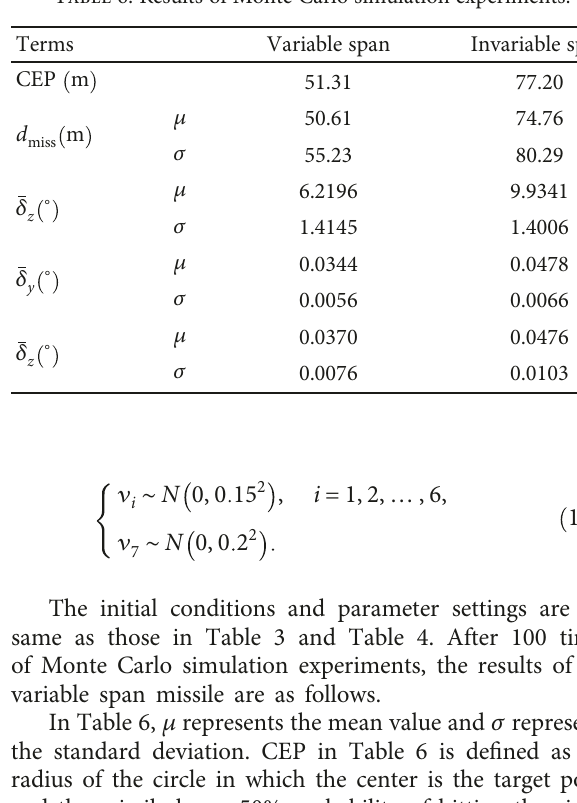
Figure 17: Curves representing the missile ’ s position projected onto the launch coordinate frame.